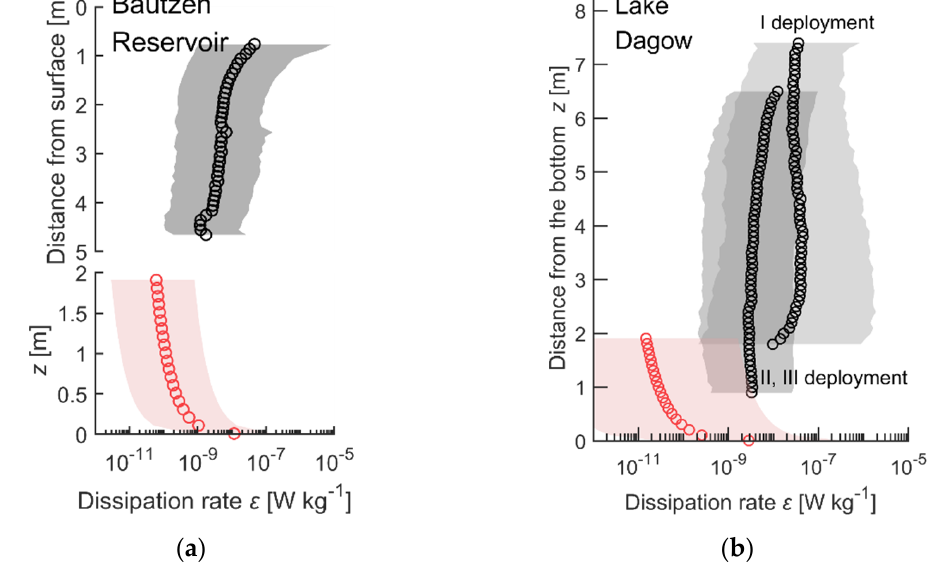
Figure 7. Vertical profiles of log-averaged energy dissipation rates ( ε ) for all available data (gray and red shaded areas show the 5th to 95th range of data): ( a ) combined data with dissipation rates calculated using the structure function and inertial subrange fitting methods (black circles, the platform-mounted ADCP facing downward) and using bottom boundary layer approach (see Section 2.4, red circles, the ADCP deployed at the bottom) in Bautzen Reservoir. The vertical axis is split into two subaxes with identical scaling: The lower axis corresponds to the distance from the bottom, the upper— to the distance from the surface. Thus, we avoid averaging over the entire water column because the water level change was significant throughout the measurements. Data are based on measurements in Bautzen Reservoir. ( b ) Dissipation rate calculated using the structure function method and the BBL approach based on measurements in Lake Dagow (separately for the first and for the following two ADCP deployment periods).